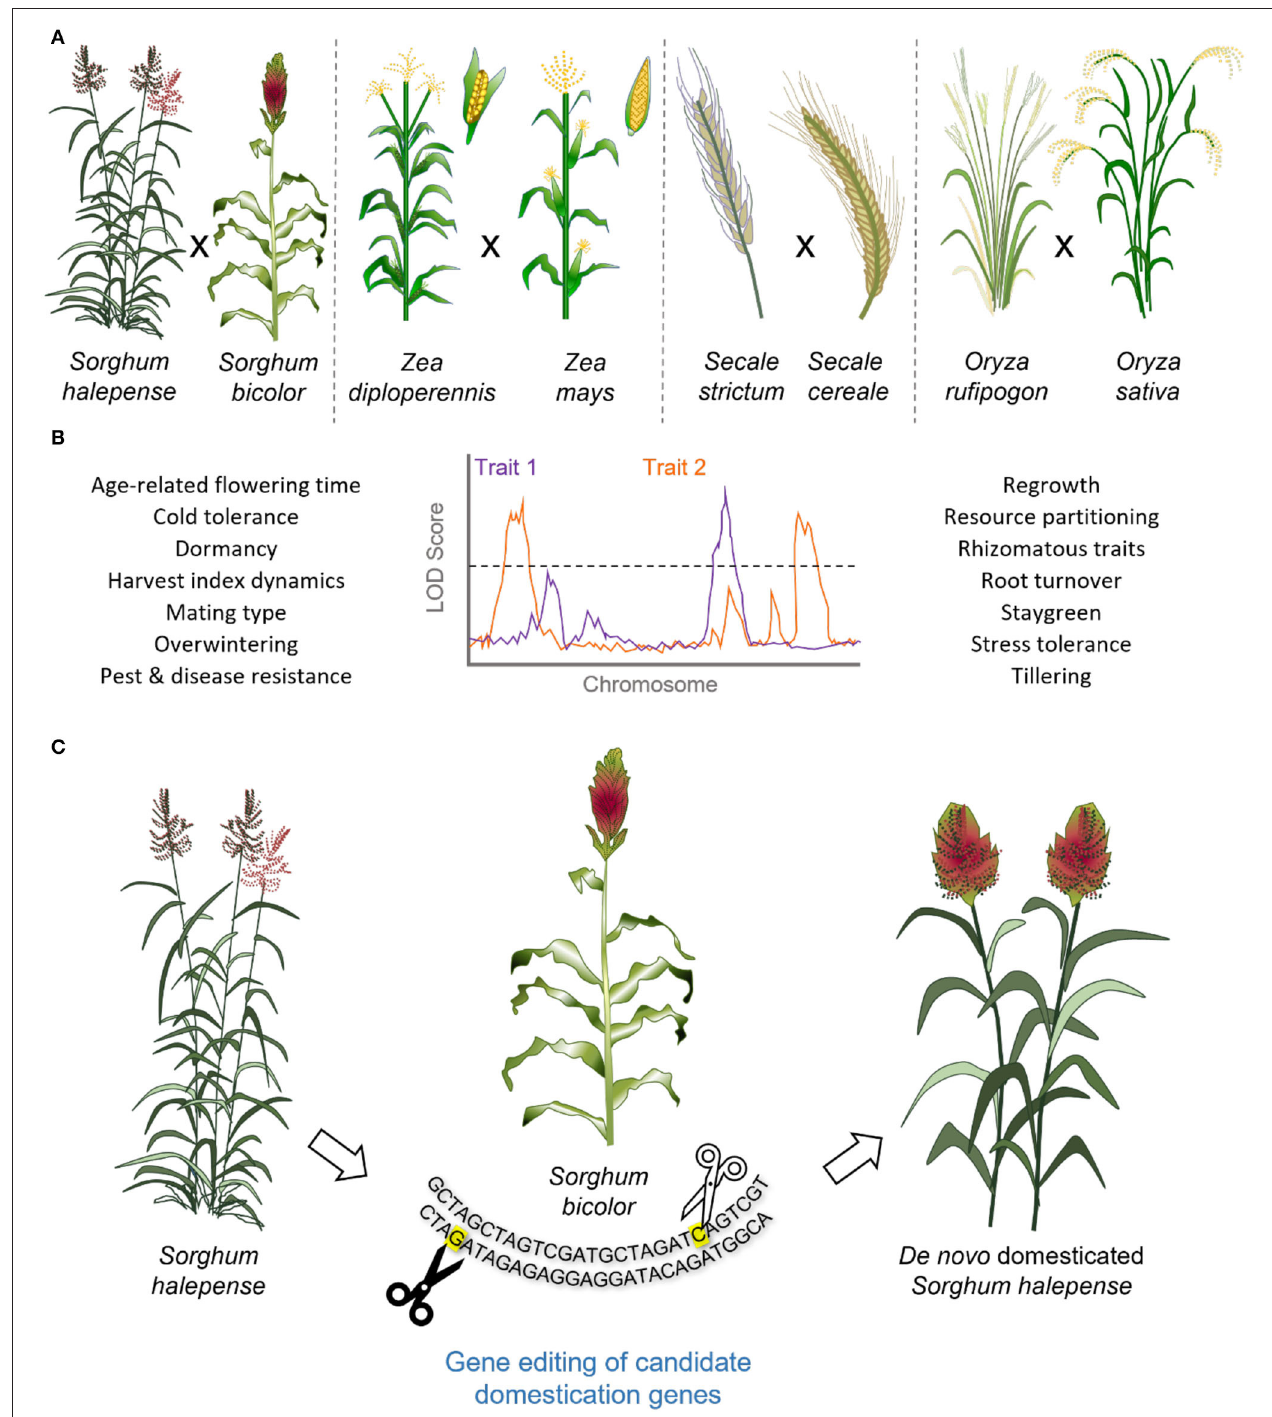
FIGURE 3 | The genetics of perennialism and de novo domestication of perennial grain crops. (A) Interspecific crosses between perennial relatives and their annual counterparts have been attempted to facilitate QTL analysis and genetic mapping of traits associated with perennialism. (B) Perennialism is a complex trait, associated with distinct physiological characteristics and responses to the environmental cues, stresses, diseases, and pests. (C) Accelerated domestication of perennial grasses through gene editing of domestication related genes, as identified in their annual relatives, could be used in de novo domestication and generation of high-yielding perennial grain crops, illustrated for Sorghum sp . The QTL plot reported is for the illustrative purposes only and emphasizes the polygenic nature of perennialism.